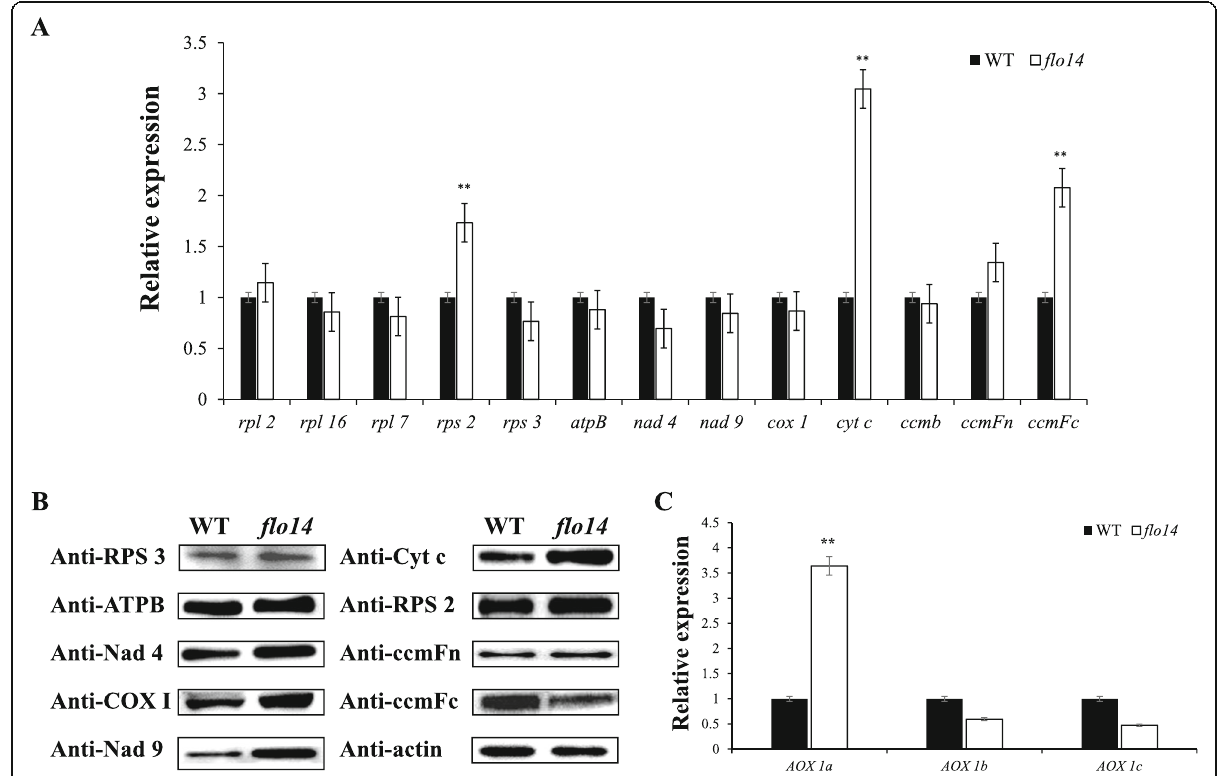
Fig. 7 Expression analysis of OsNPPR3 and genes associated with mitochondria. a Real-time RT-PCR analysis of the mitochondrial gene expression in endosperms of wild type (WT) and flo14 mutant ( flo14 ) at 12 days after flowering (DAF). b Immunoblotting analysis of mitochondria related proteins in developing endosperm of wild type and flo14 mutant. c Real-time RT-PCR analysis of the gene expression in the wild type and flo14 mutant. Data are shown as means ± SD from three independent biological replicates and compared by Student ’ s t -test (* P < 0.05, ** P < 0.01). Actin1 was used as an internal control. rpl2 : ribosomal protein L2 , rpl16 : ribosomal protein L16 , rpl7 : ribosomal protein L7 , rps2 : ribosomal protein S2 , rps13 : ribosomal protein S13 , cox1 : cytochrome c oxidase subunit 1 , cyt c : cytochrome C , ccmb: cytochrome c biogenesis B , ccmFn : cytochrome c biogenesis Fn , ccmFc: cytochrome c biogenesis Fc , nad4 : NADH dehydrogenase subunit IV , nad9 : NADH dehydrogenase subunit XI , AOX 1a : alternative